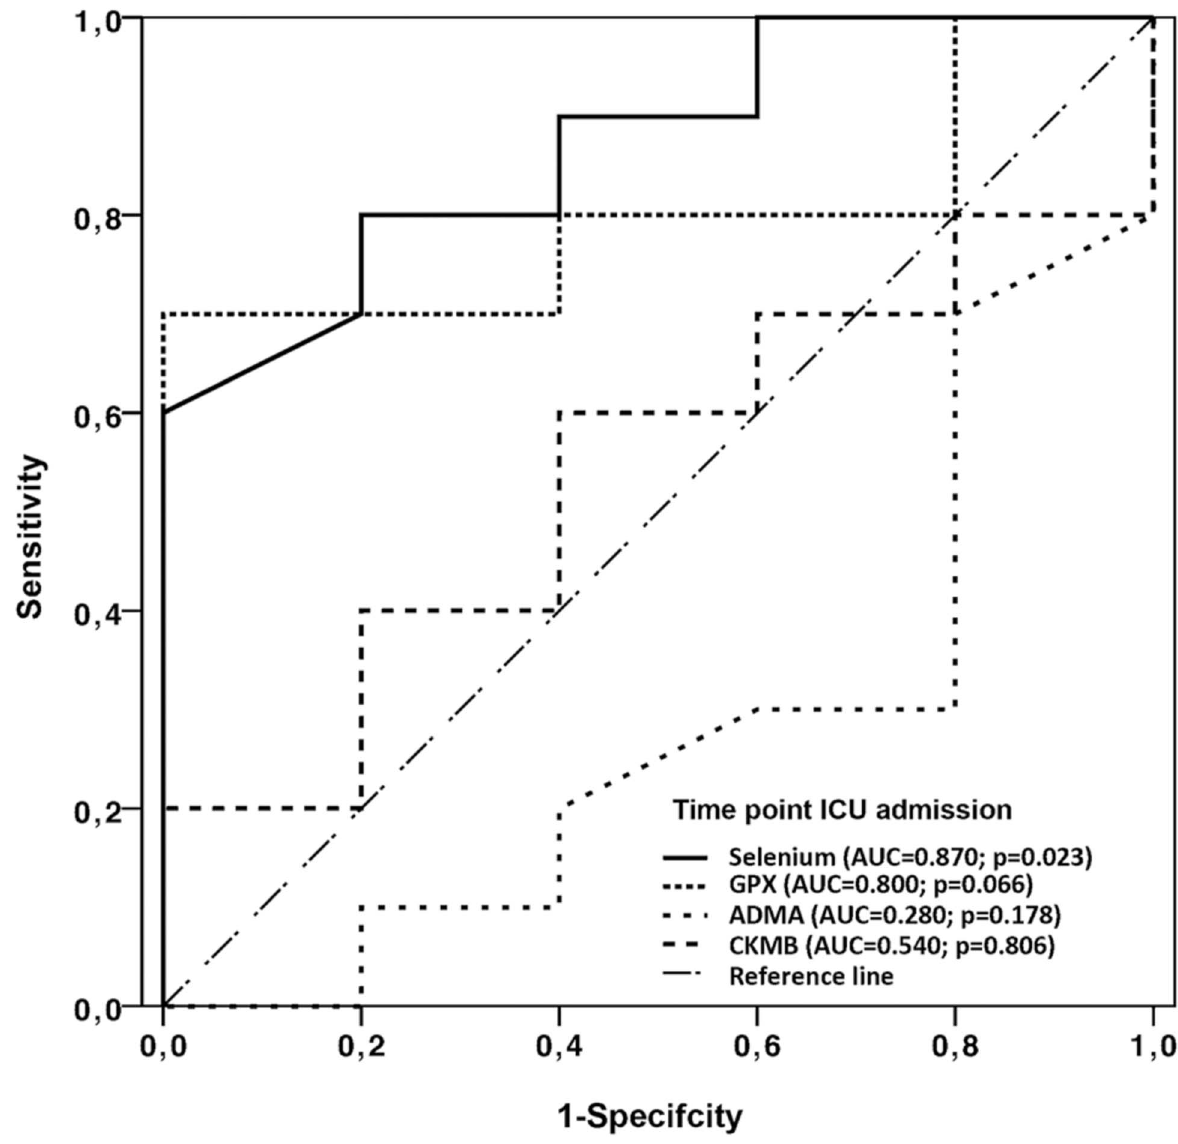
Figure 6. Receiver operating characteristic curve (OPCAB group). Receiver operating characteristic curve for the significance of postoperative (admission to ICU) selenium, GPx, ADMA and CK-MB concentrations in the OPCAB group to predict the development of organ dysfunction in the postoperative period. AUC, area under the receiver operating curve.